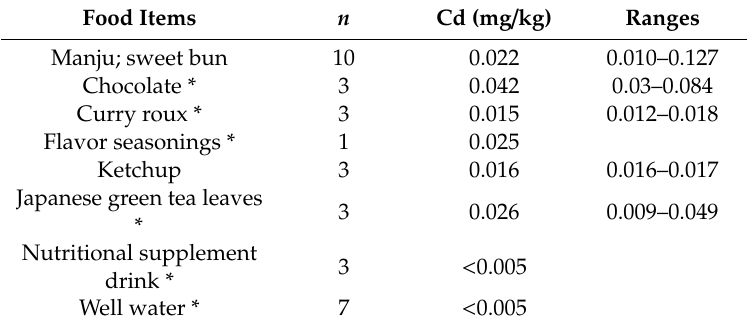
Table 10. Cadmium (Cd) concentrations in others. Data are presented as arithmetic